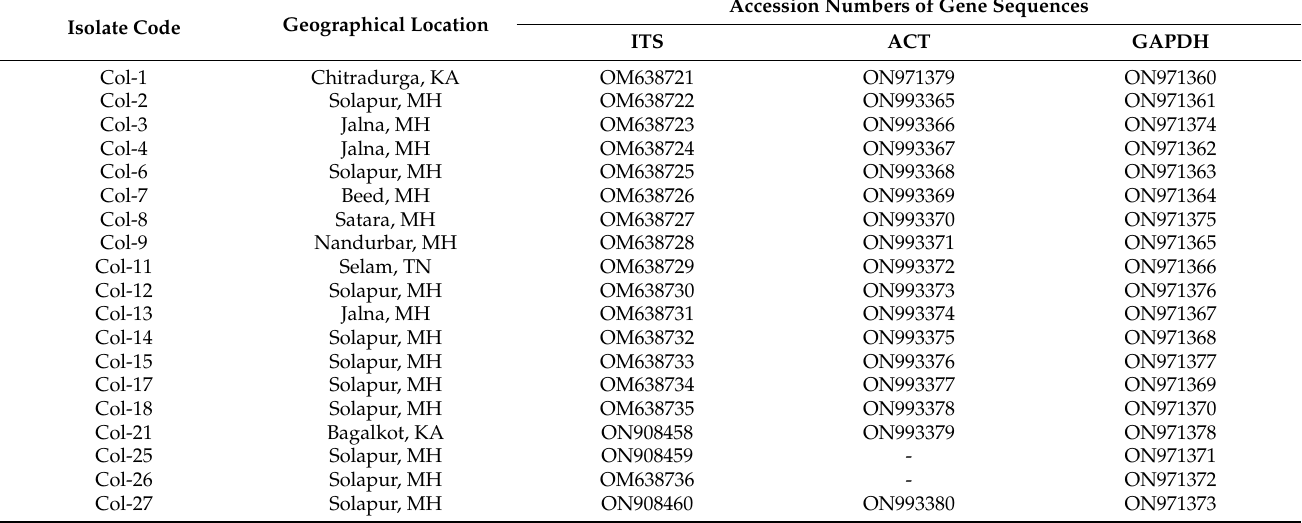
Table 3. Geographical origin and accession numbers of gene sequences of Colletotrichum isolates from pomegranate fruits characterized in the current